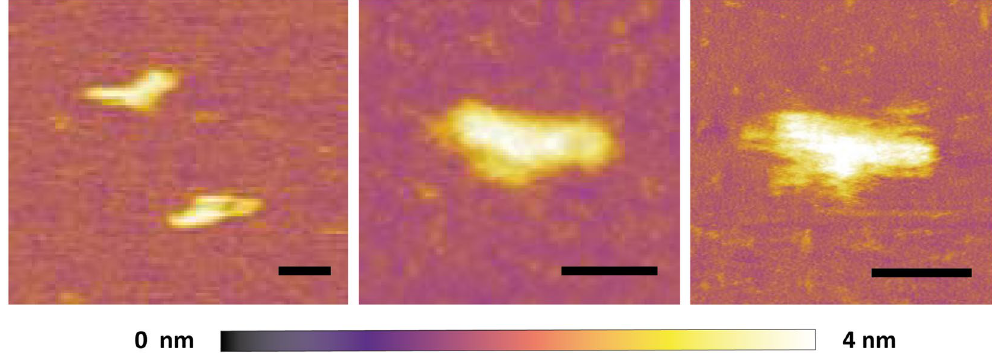
Figure 7. Detailed AFM images of RNA origami using a Cypher ES AFM, Asylum Research equipped with direct laser excitation (blueDrive); scale bar 20